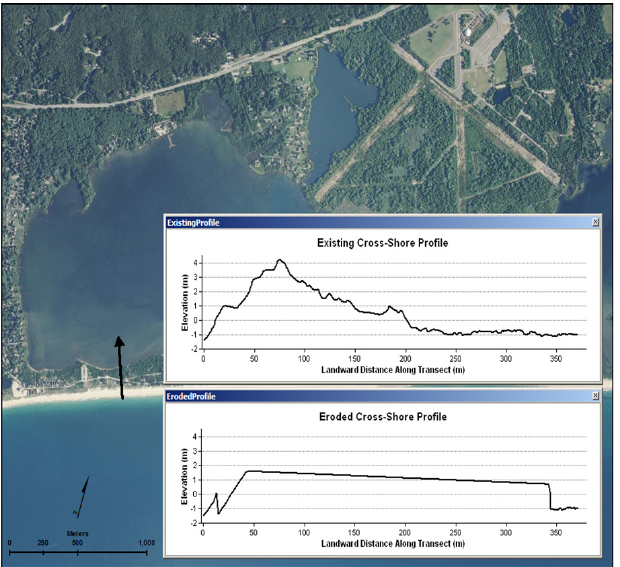
Figure A2. Existing and eroded cross shore profiles for the dunes at Quonochontaug and Charlestown. For eroded profile: dune toe to dune crest (1.6 m NAVD88), foreshore slope: 11%, and landward slope: 0.3% (300 m from crest) representing over ‐ wash fan, after 300 m, reverts to existing bathymetry.